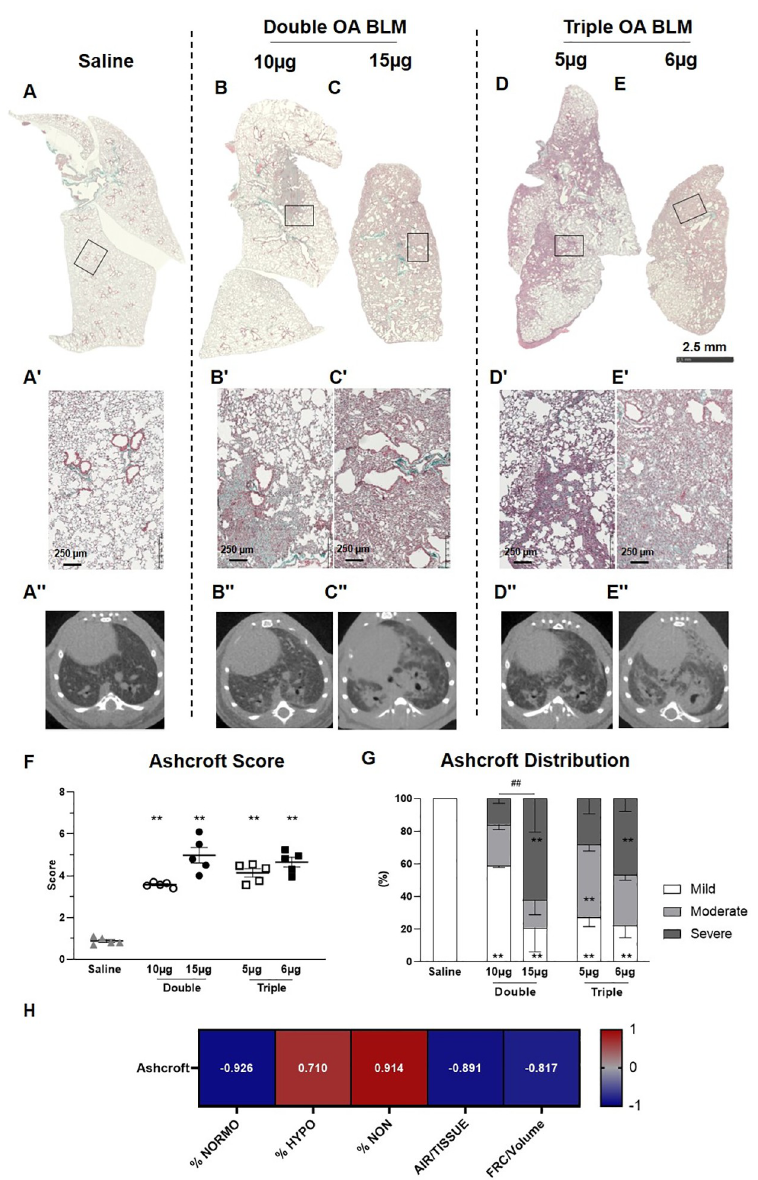
Fig 4. Histological staining. Representative micro-photographs of saline (A), BLM-double treated groups (B, C) and BLM-triple treated groups (D, E) stained with Masson’s trichrome at day 28. The squares indicate the selected zone with higher magnification (A´-E´). Representative transversal micro-CT scans of saline (A’’), double BLM-treated groups (B’’, C’’) and triple BLM-treated groups (D’’, E’’). (F) Ashcroft score for the saline and BLM groups. (G) Ashcroft frequency distribution in saline and BLM groups. (H) Spearman’s correlation between micro-CT parameters and Ashcroft Score. Data are shown as mean ± SEM. Statistical analysis was performed between the animal groups by one-way ANOVA followed by Tukey’s test ( � p < 0.05, �� p < 0.01 vs. saline; ## p < 0.01 comparing low and high doses in double and triple OA groups, respectively). N = 5 per group. double (10, 15 μ g) and triple (5, 6 μ g) BLM treatment caused patchy fibrotic alterations of lung parenchyma characterized by fibroproliferative foci with various degrees of confluence at 28 days (Fig 4B–4E). On contrary, any parenchymal alteration was reported in the saline group (Fig 4A).